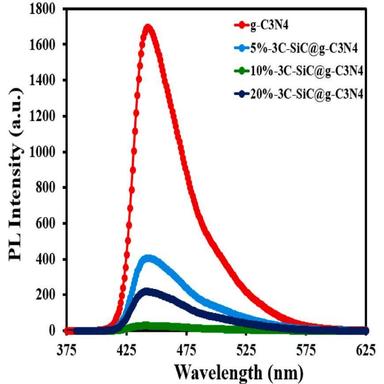
PL spectrum of pure g-C3N4, 5%-3C–SiC@g-C3N4, 10%-3C–SiC@g-C3N4, and 20%-3C–SiC@g-C3N4.